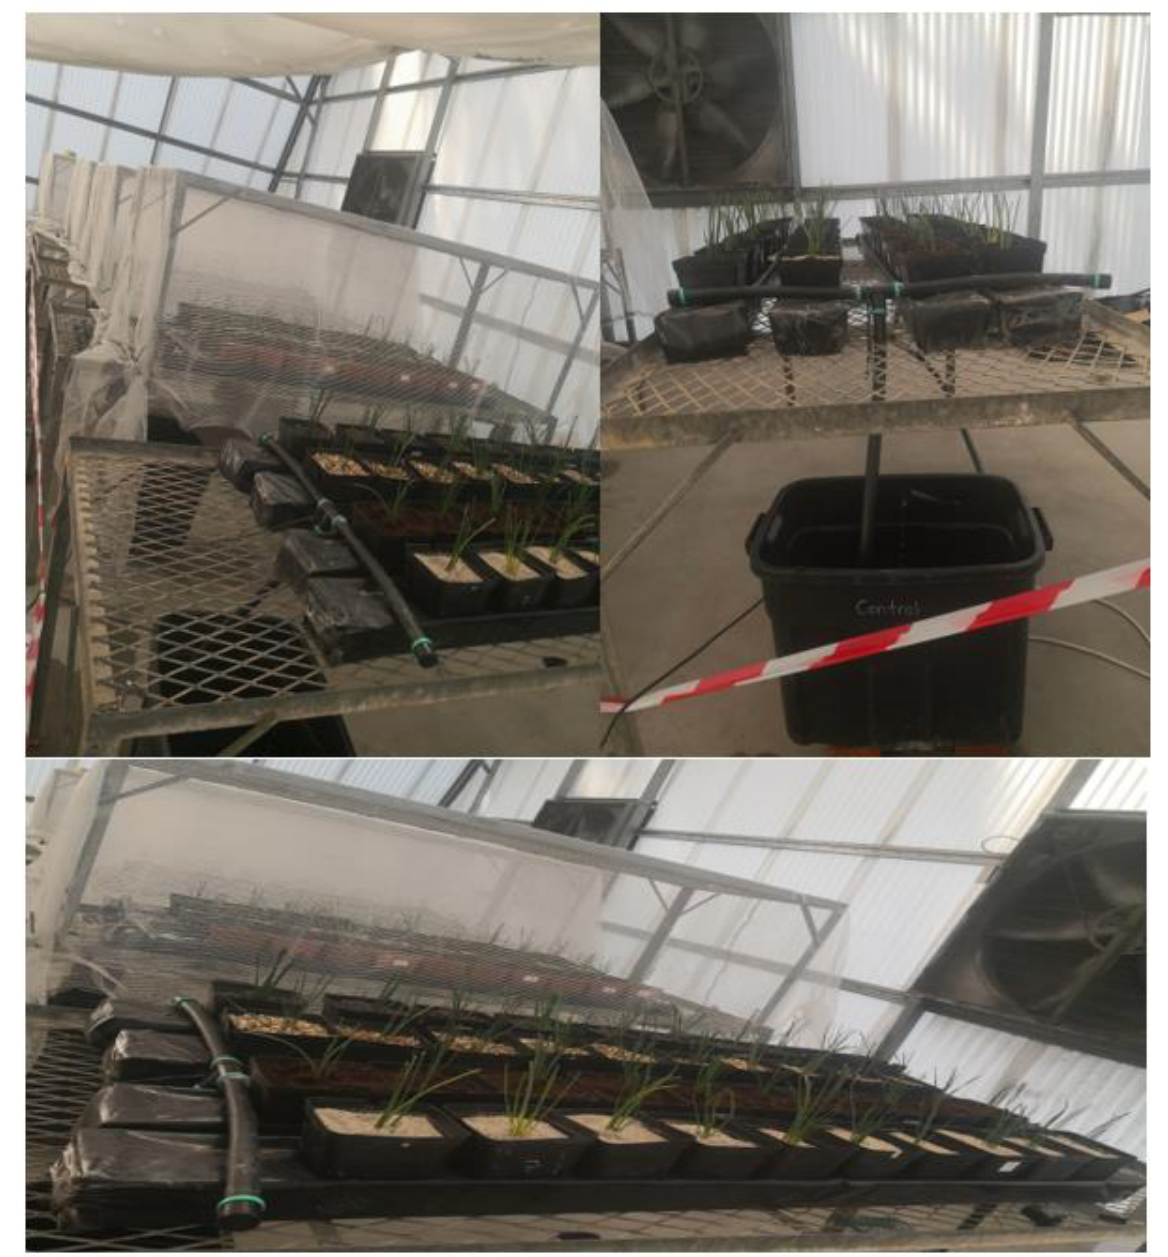
Figure 1. Arrangement of each gutter on four NFT systems with different media and shade levels.